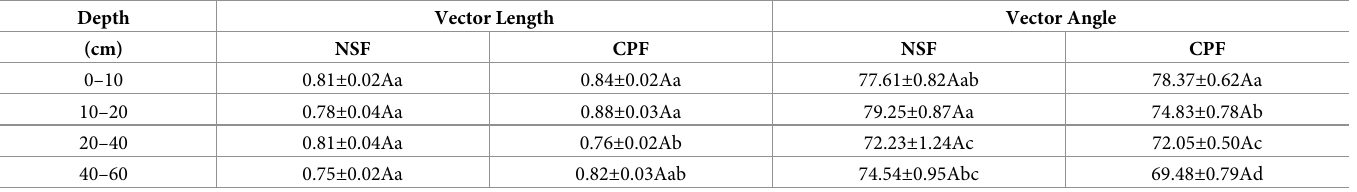
Values represented mean ± standard error (n = 3). Capital letters show the significant difference between the two forests at the same soil depth, and the different lower cases reflect the significant difference between soil depths within one forest